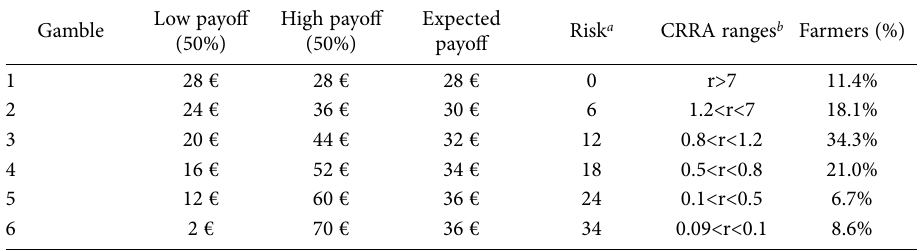
a The risk is calculated as the standard deviation of the expected payoff. b CRRA ranges are calculated as the range of r in the function U(x)= x (1−r) /(1−r) for which the subject chooses each gamble assuming constant relative risk aversion